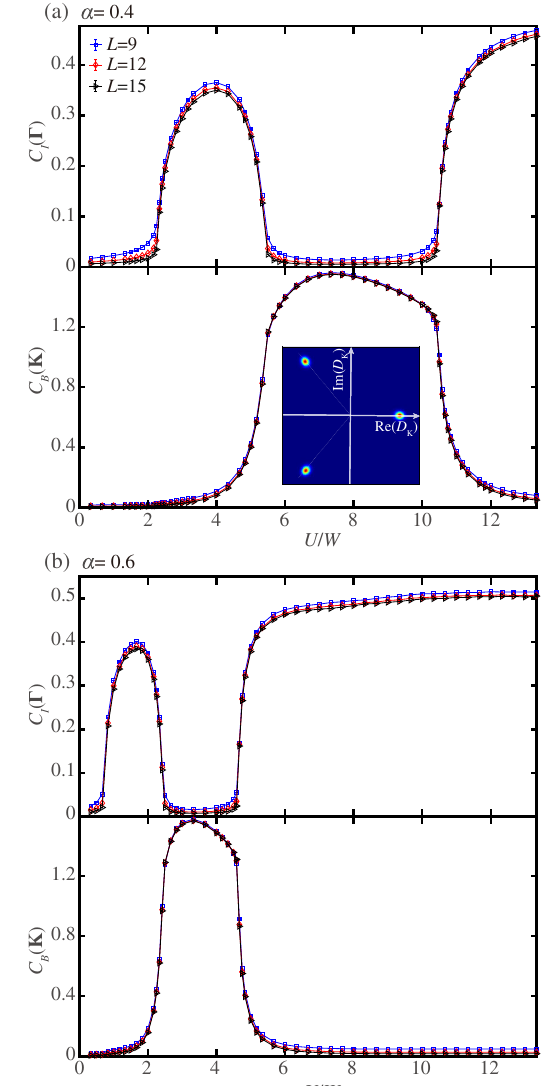
FIG. 4. IVC and cVBS insulating states. Correlation functions C Γ Þ and C K Þ , indicative of IVC and cVBS orders, respec- I ð B ð tively, as a function of U=W for (a) α ¼ 0 . 4 and (b) α ¼ 0 . 6 . Linear system sizes are indicated in the legend. In both panels, the QVH-IVC transition, the IVC-cVBS transition, and the cVBS- IVC transition are all first order. The inset in panel (a) presents the histogram of the complex bond order parameter D K at U=W ∼ 5 . 3 . The positions of the three peaks are those expected for a cVBS phase instead of a pVBS